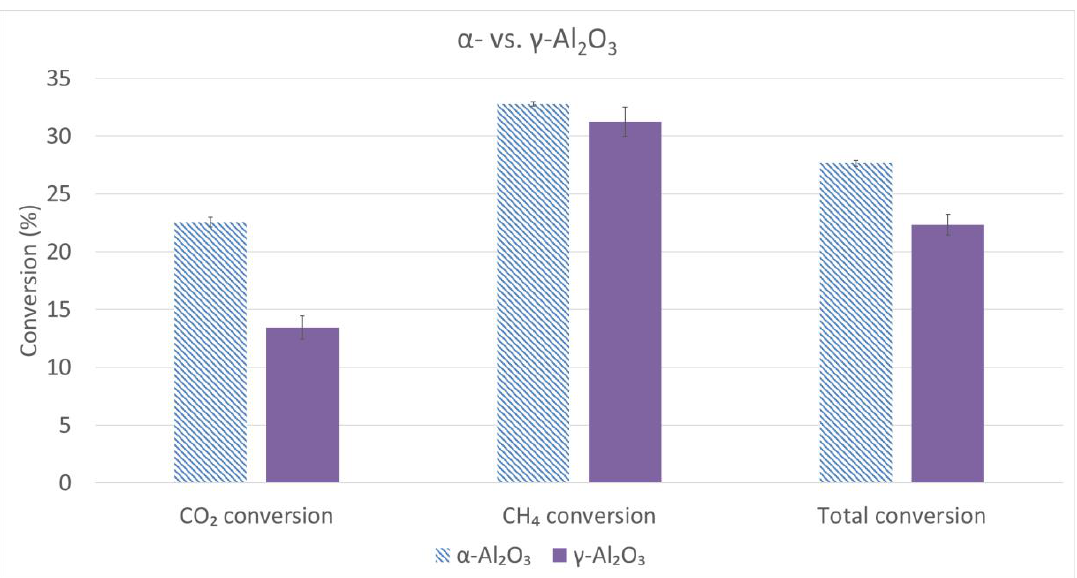
Figure 5. Comparison of the CO 2 , CH 4 and total conversion between γ -Al 2 O 3 and α -Al 2 O 3 (2.0–2.24 mm spheres).